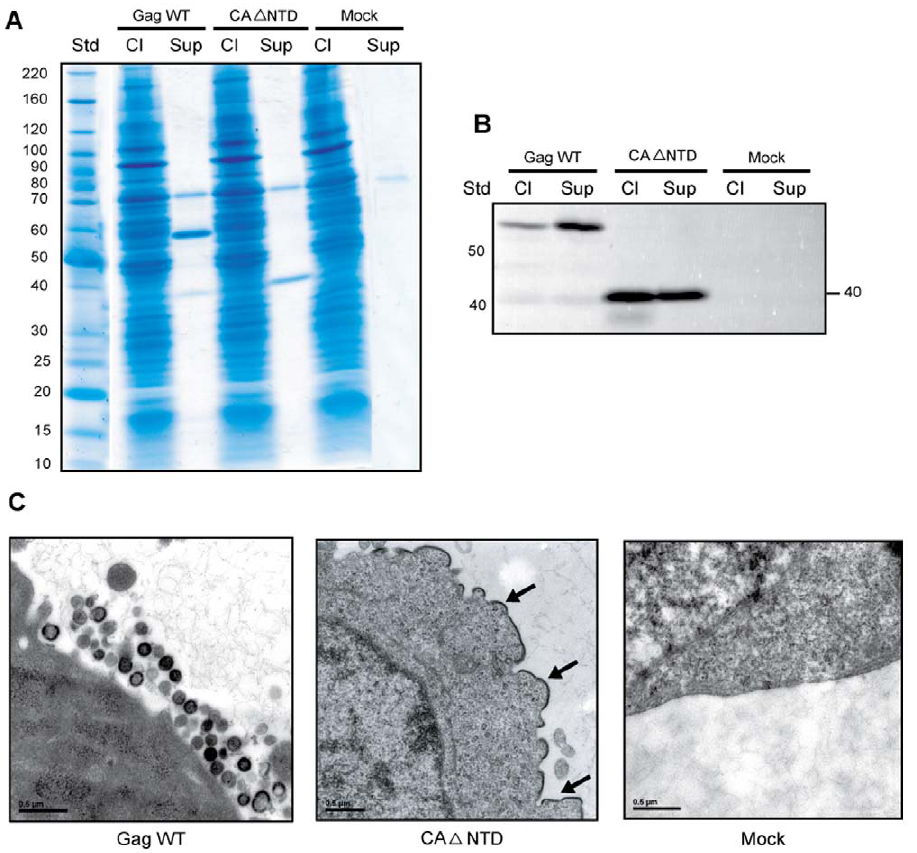
Figure 8. Domains NC and p6 are required for VLP release, although they can be replaced with heterologous hCREB and p2b sequences. (A) 293T cells were transfected either with Gag WT or expression vectors encoding for NC or P6 mutants (i.e. D p6, D NCp6, p6 449 LD and NCp6 378 LZLD). At 48 h post-transfection, cell lysates and cell-free supernatants were analyzed on gradient SDS-PAGE and protein stained with Coomassie Brilliant Blue. (B) In parallel, an IP assay was performed using the anti-p24 antibody on the same samples. Precipitated proteins were run on SDS-PAGE and Gag proteins were analyzed by WB. (C) Transfected 293T cells were analyzed by TEM (magnification: 6 50,000). The Biochemical experiments shown are representative of at least three independent experiments and two for the microphotographs.